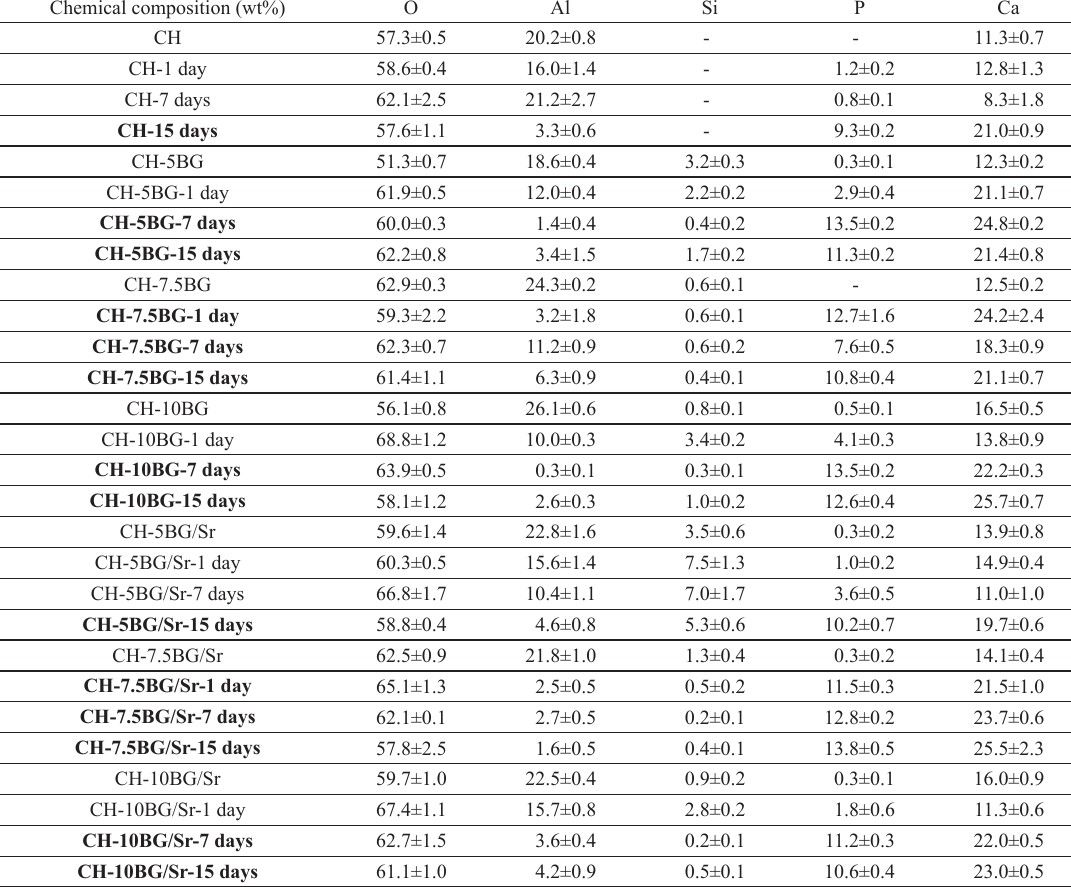
Table 1. EDX analyses of the blend’s surfaces before and after the interaction with SBF for 1, 7 and 15 days. Chemical composition (wt%)